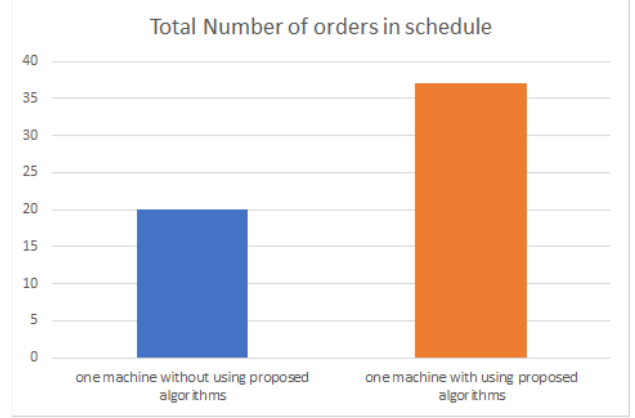
Figure 6. The performance of the number of orders for one machine.